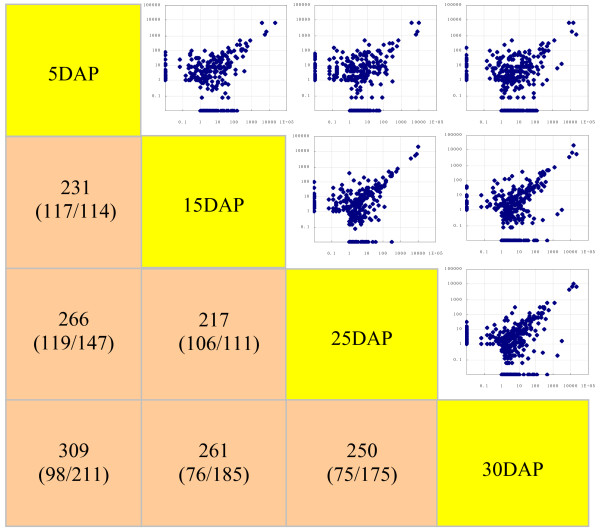
Scatter plots and comparisons of expression profiles at four developmental stages. Values represent number of miRNAs differentially repressed/induced between stage-pairings.